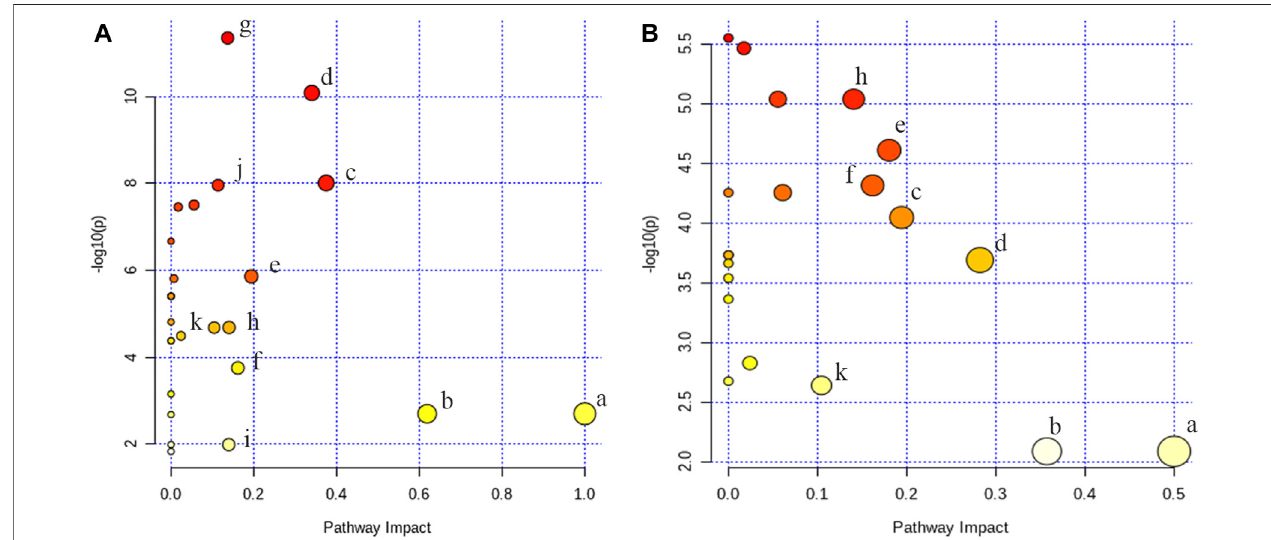
FIGURE 6 | Analysis of metabolic pathways (A) control vs model (B) MHD vs model. a: phenylalanine, tyrosine and tryptophan biosynthesis, b: phenylalanine metabolism, c: tryptophan metabolism, d: arginine and prolinemetabolism, e: nicotinate and nicotinamide metabolism, f: retinol metabolism, g: arginine biosynthesis, h: TCA cycle, i: tyrosine metabolism, j: alanine, aspartate and glutamate metabolism k: cysteine and methionine metabolism.